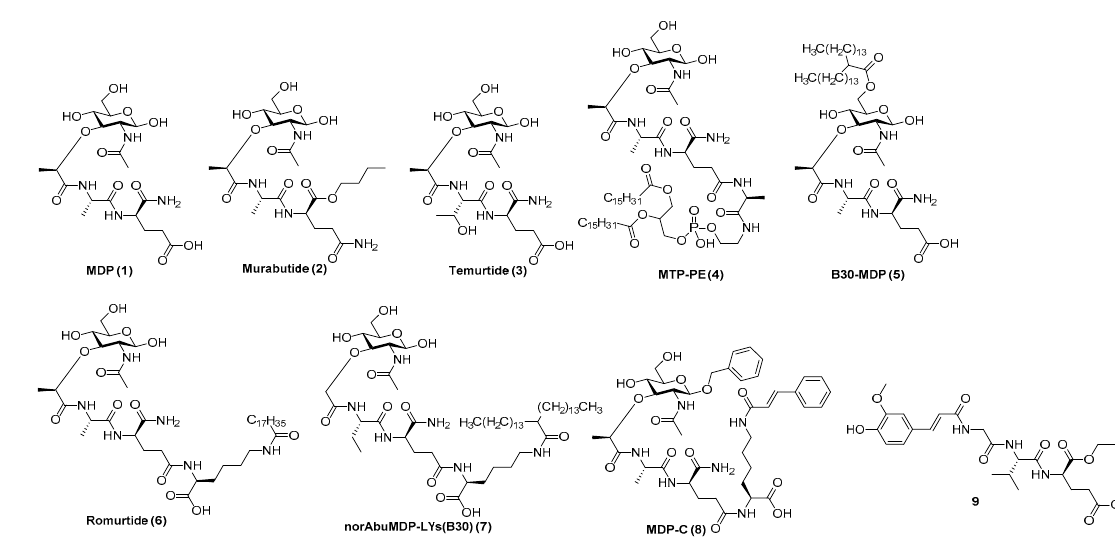
Figure 4. MDP ( 1 ), its most prominent pharmacologically active derivatives ( 2 – 8 ) and a desmuramylpeptide derivative with NOD2 activity ( 9 ).